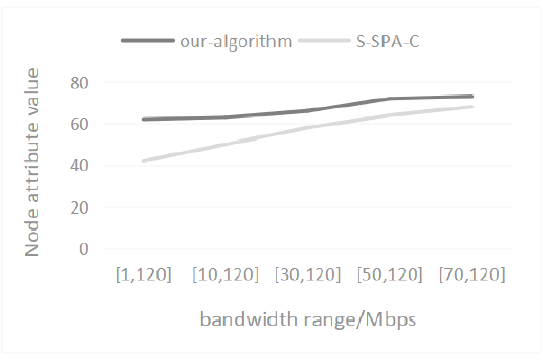
Figure 11. Node attribute diagram selected by S-SPA-C and our algorithm in different link bandwidth attributes.